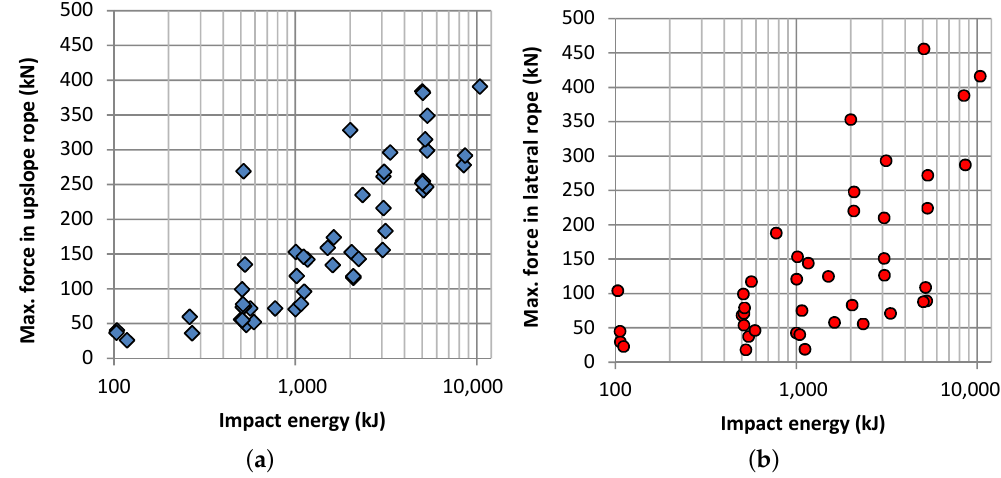
Figure 12. Maximum forces in ( a ) the upslope ropes and ( b ) the lateral suspension ropes with respect to the impact energy classes (energy class >4500 expanded to show effective impact energy).